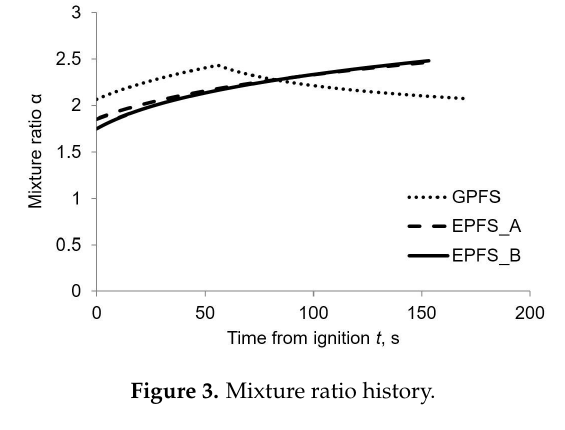
Figure 3. Mixture ratio history.